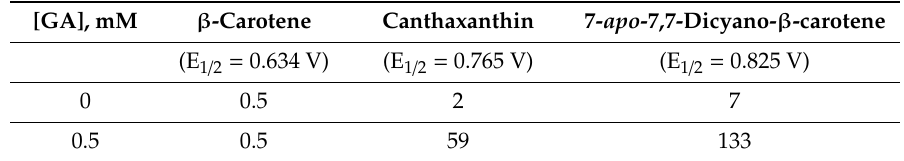
Table 1. Relative scavenging rate constants of OOH radicals by carotenoids and their GA complexes (k / k ST ) in DMSO. E 1 / 2 is the redox potential of carotenoids (in Volts vs. SCE) referenced to ferrocene. [17,59]. [GA], mM β -Carotene